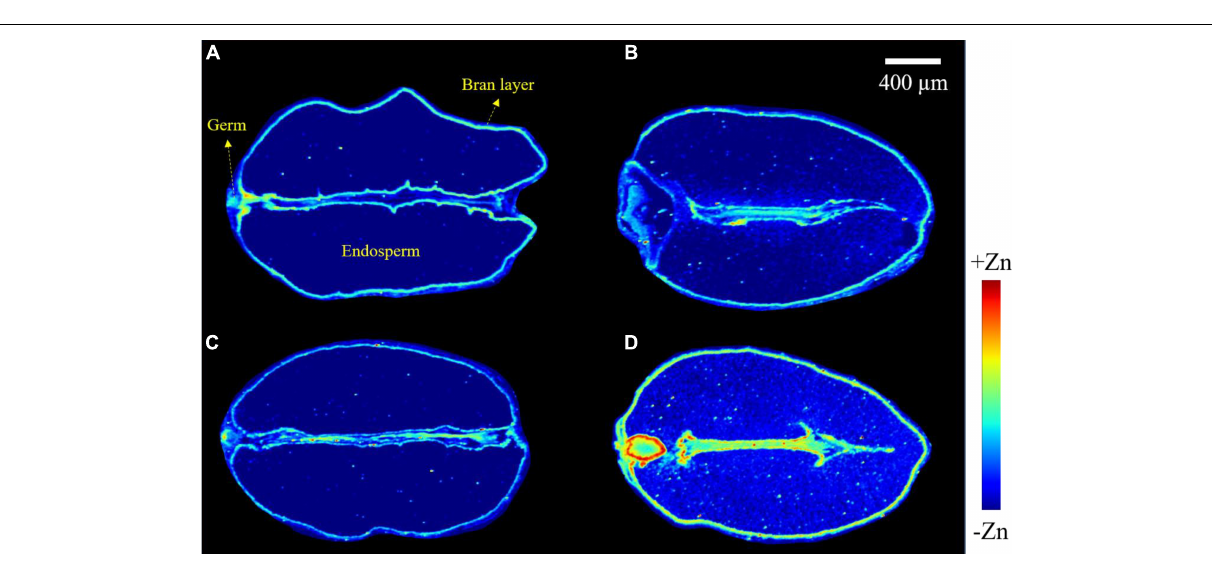
Frontiers in Plant Science |